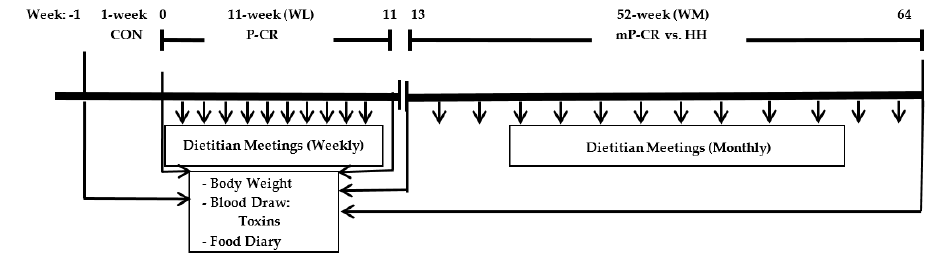
Figure 2. Study Timeline.